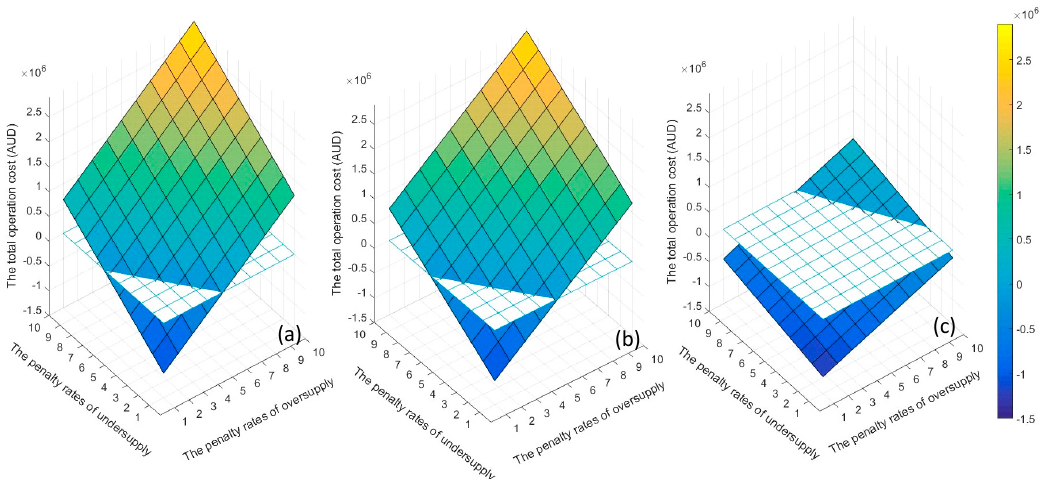
Figure 7. The optimisation results as a function of the penalty rates. ( a ) The total operation cost of Case DD; ( b ) The total operation cost of Case DR; ( c ) The total operation cost of Case MR. The coloured legend on the right side is in AUD.